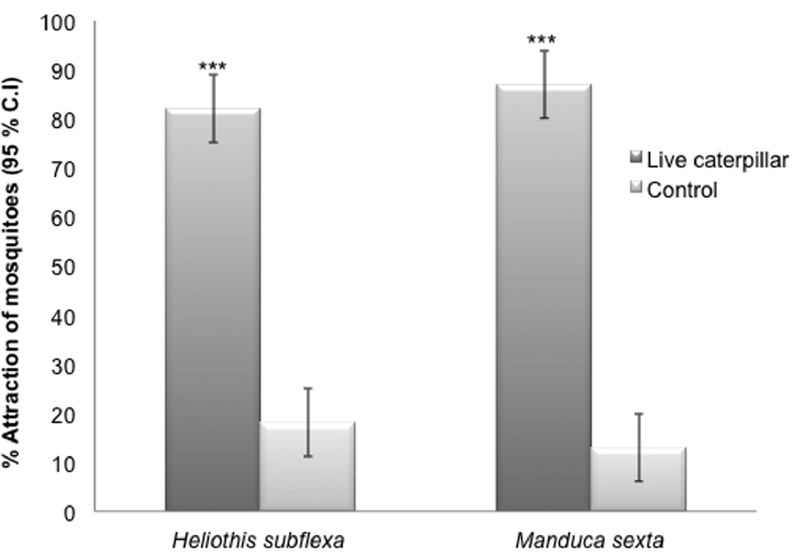
Figure 2. Y-tube olfactometer choice assays showing the percentage of female An.stephensi ( ± 95% binomial confidence intervals (C.I.)) that were attracted to live fourth instar larvae of Heliothissubflexa and Manducasexta (black bars) versus a white cotton dental wick of the same size used as a blank control (light bars). Asterisks denote significantly different levels of attraction (Chi-square 2 6 2 test of independence; *P , 0.05; **P , 0.01; ***P , 0.001; N=90).